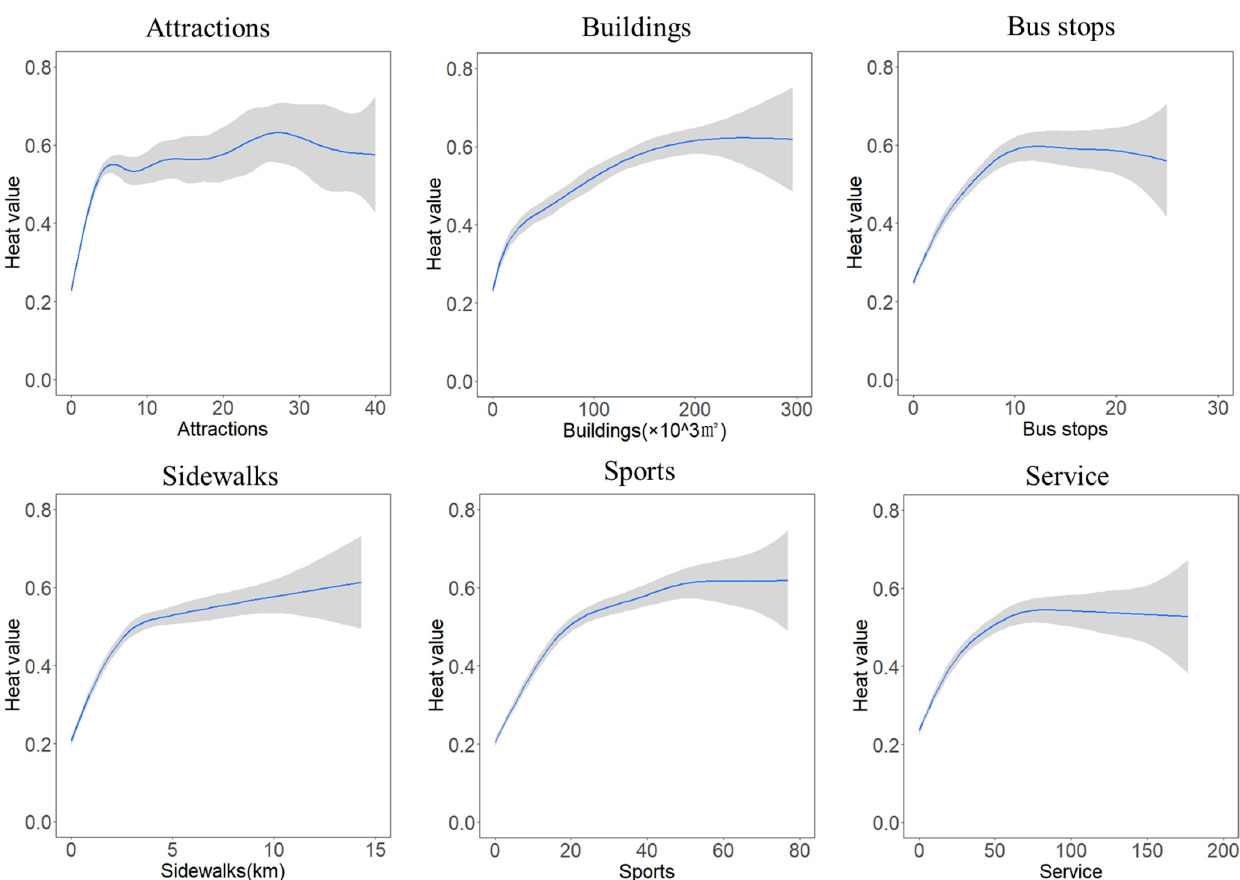
Figure 8. Response curves of running suitability values to predominant factors derived from the model.